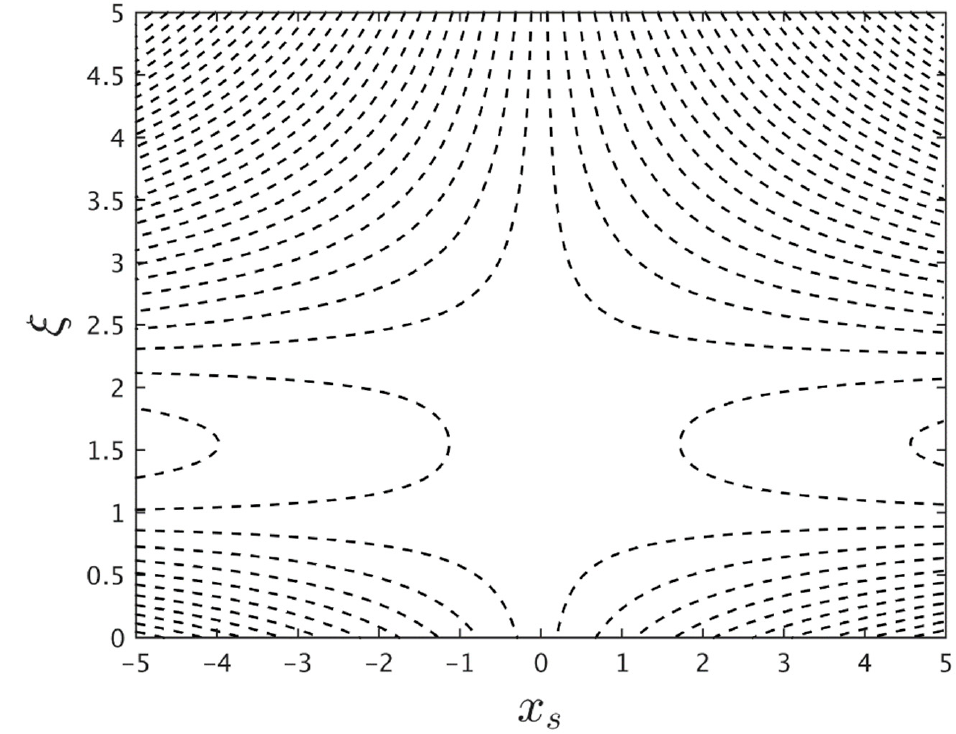
= M . Figure 19. Plot of streamlines for the lower branch solution when M c c M . c